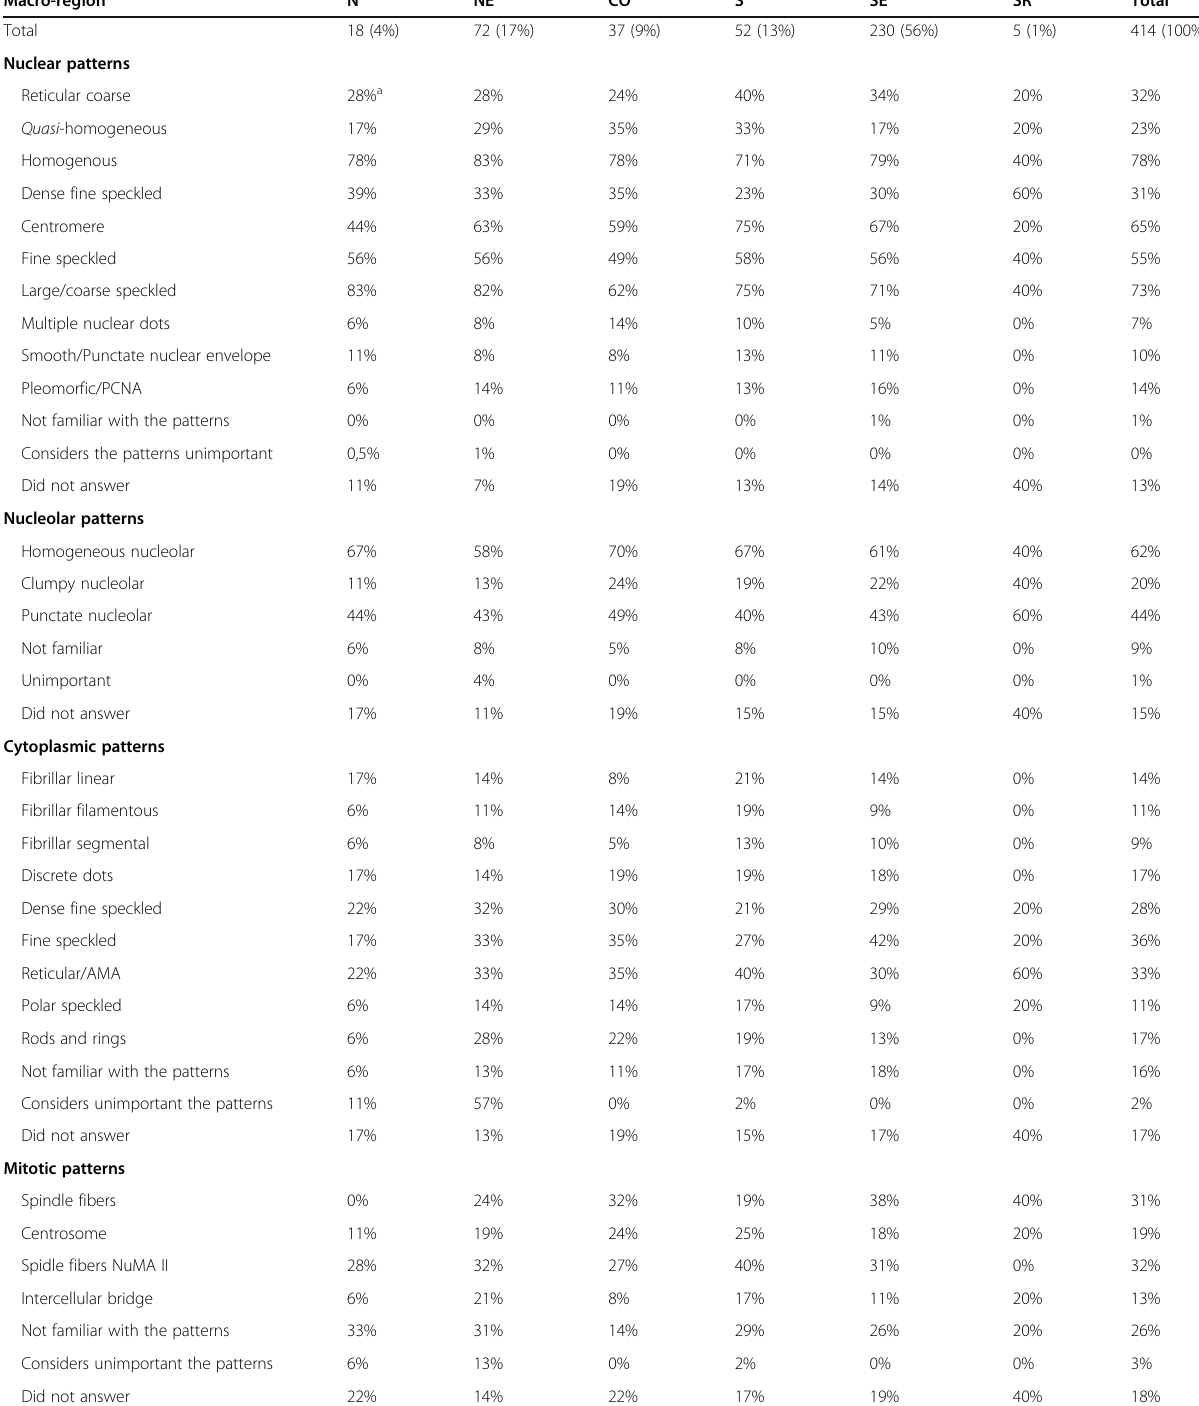
Table 5 Distribution of nuclear, nucleolar, cytoplasmic and mitotic apparatus patterns according to the relevance perceived by rheumatologists in different Brazilian